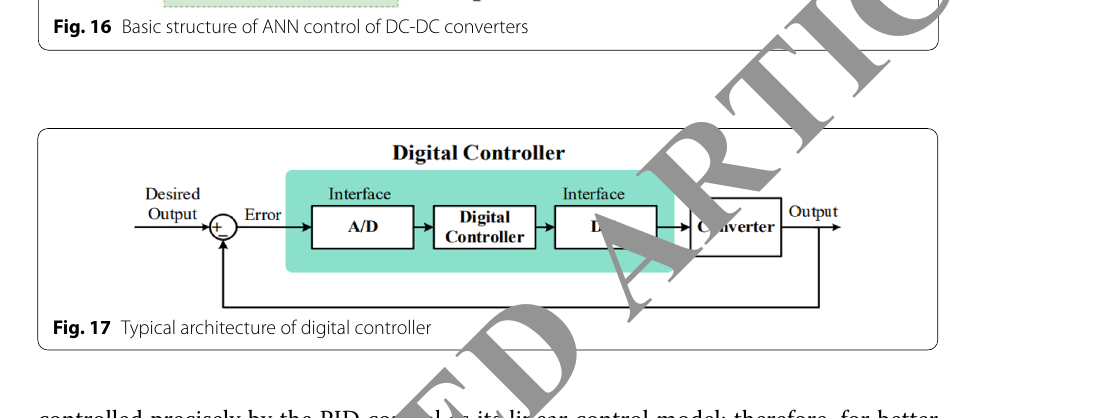
Fig. 16 Basic structure of ANN control of DC-DC converters